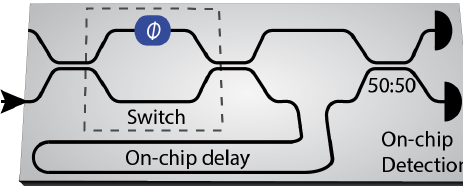
assumed to switch fully between the top and bottom path (labeled switch) by controlling the relative phase of the two interferometer arms ( ϕ ). For a z -basis measurement, the photons are guided directly to the detectors for time-resolved recording. For an x -basis measurement, the switch guides the first wave package of the time-bin encoding to the delay line and the second to the short arm. For first-level photons the delay needs to be longer and is replaced with a fiber delay line